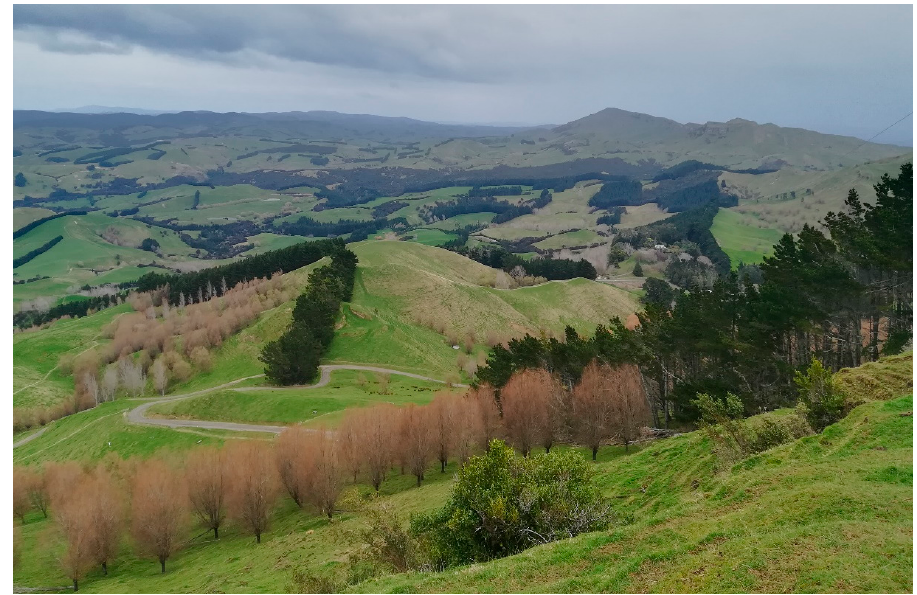
Figure 2. A typical North Island New Zealand hill country landscape 25 km north east of Dannevirke, in the Manawat ū - Whanganui region. Willows can be seen space-planted in pastures at the bottom of the slope directly beneath the photographer. The photograph was taken by the lead author.